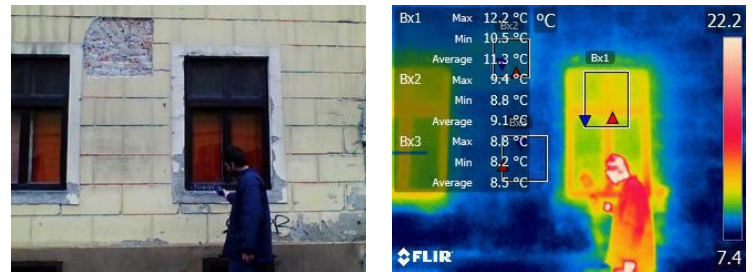
Figure 24. Termogram of Kostić house in 23 Kuhačeva Street.